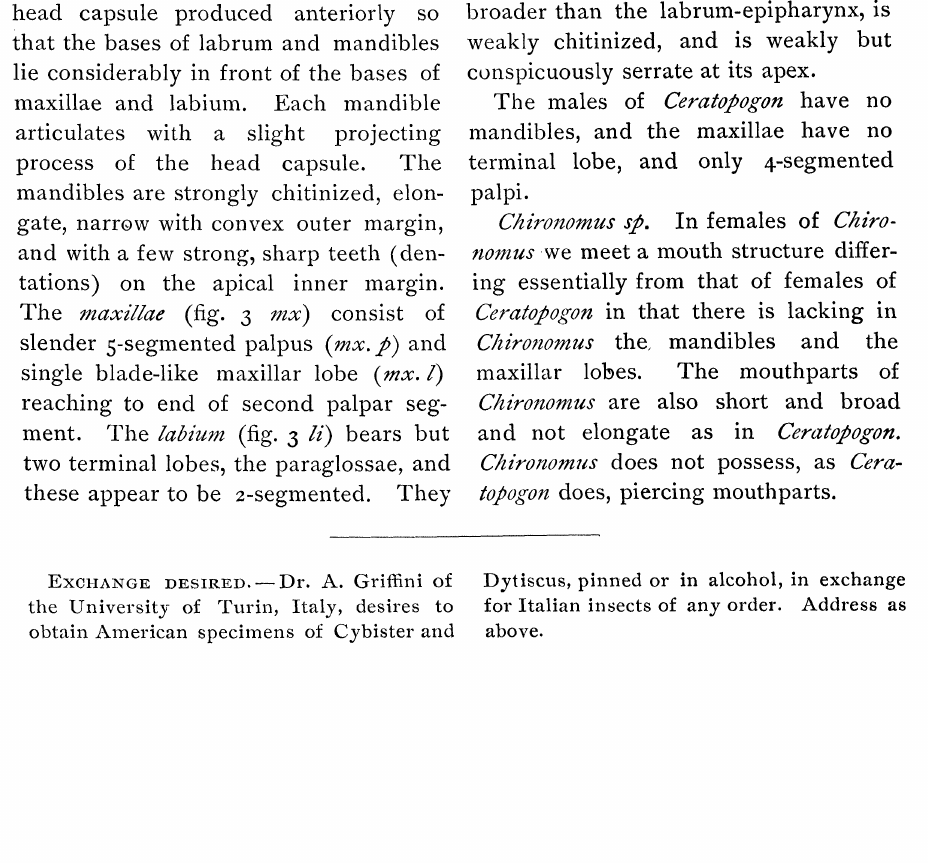
Fig. 3, Mouthparts of Ceratobogon sp., lb labrum-epipharynx, md mandible, mx maxilla,